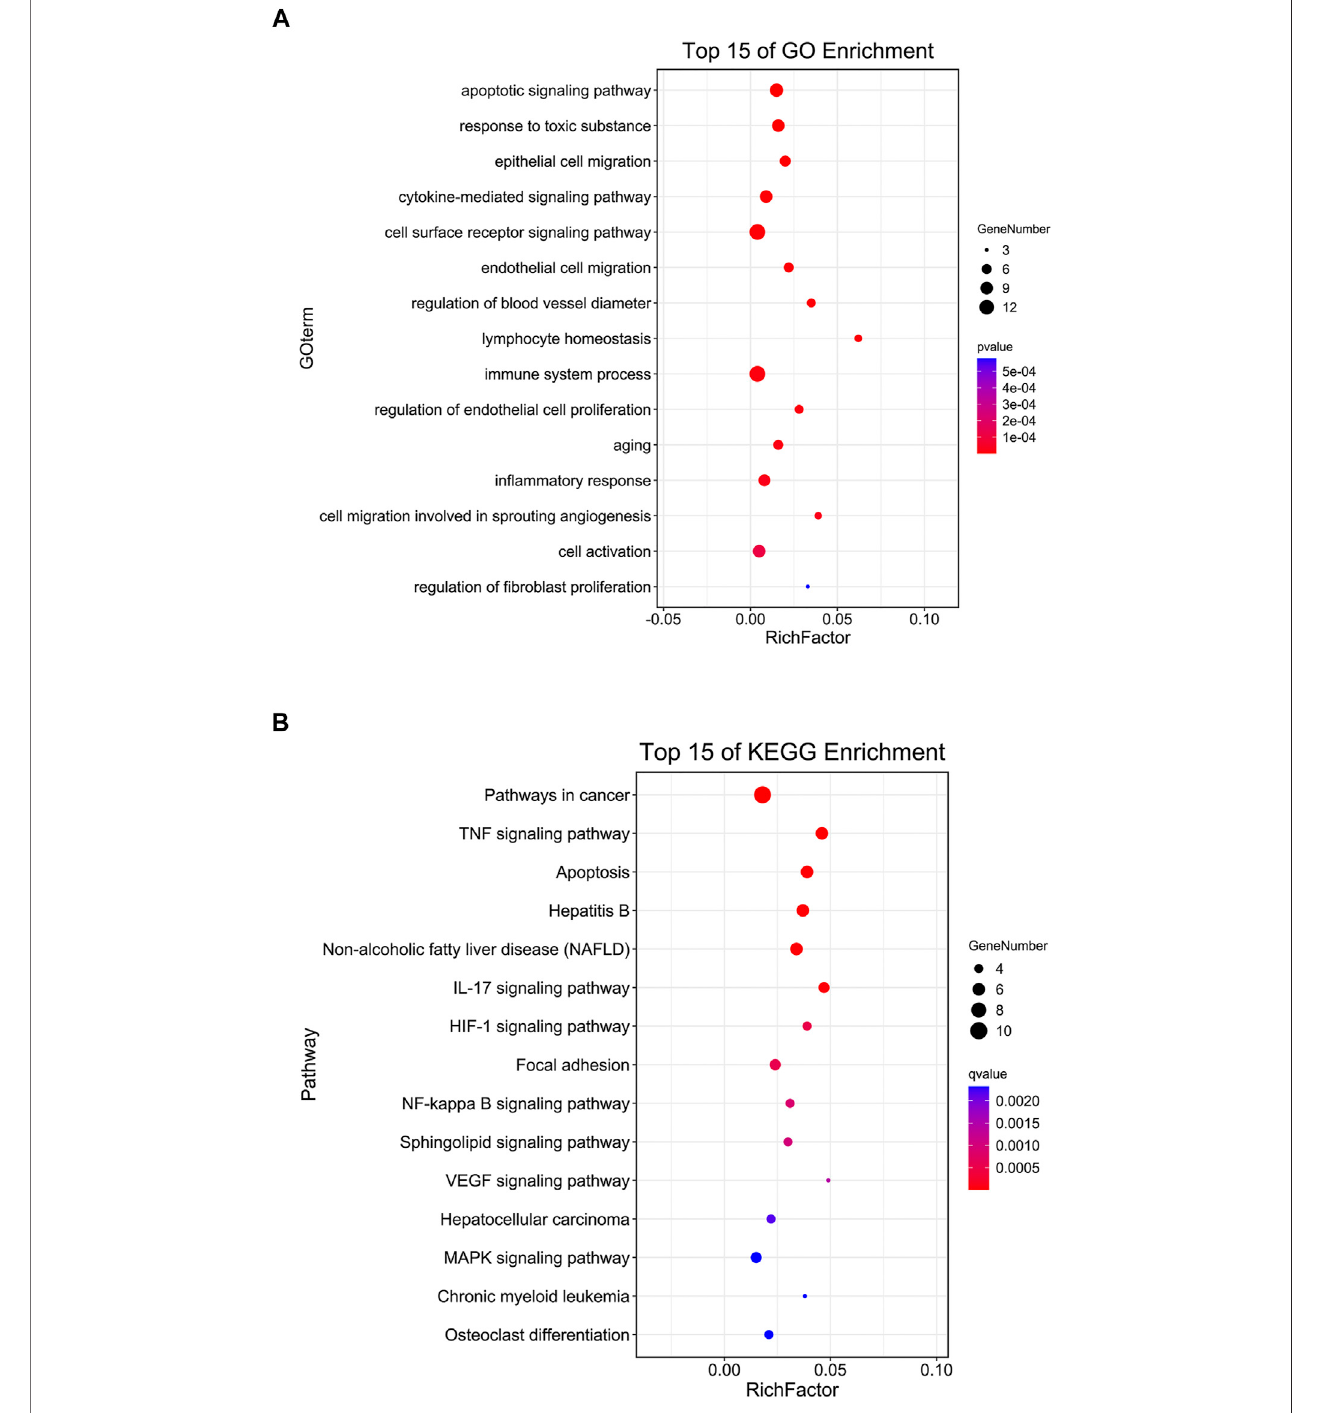
FIGURE 4 | Enrichment analysis of core targets of SNS in treating liver fi brosis based on Omicshare. A p -value cut-off of ≤ 0.05 was considered signi fi cant and the hyper-geometric test applied to identify enriched GO-BP terms (A) and KEGG pathways (B) .